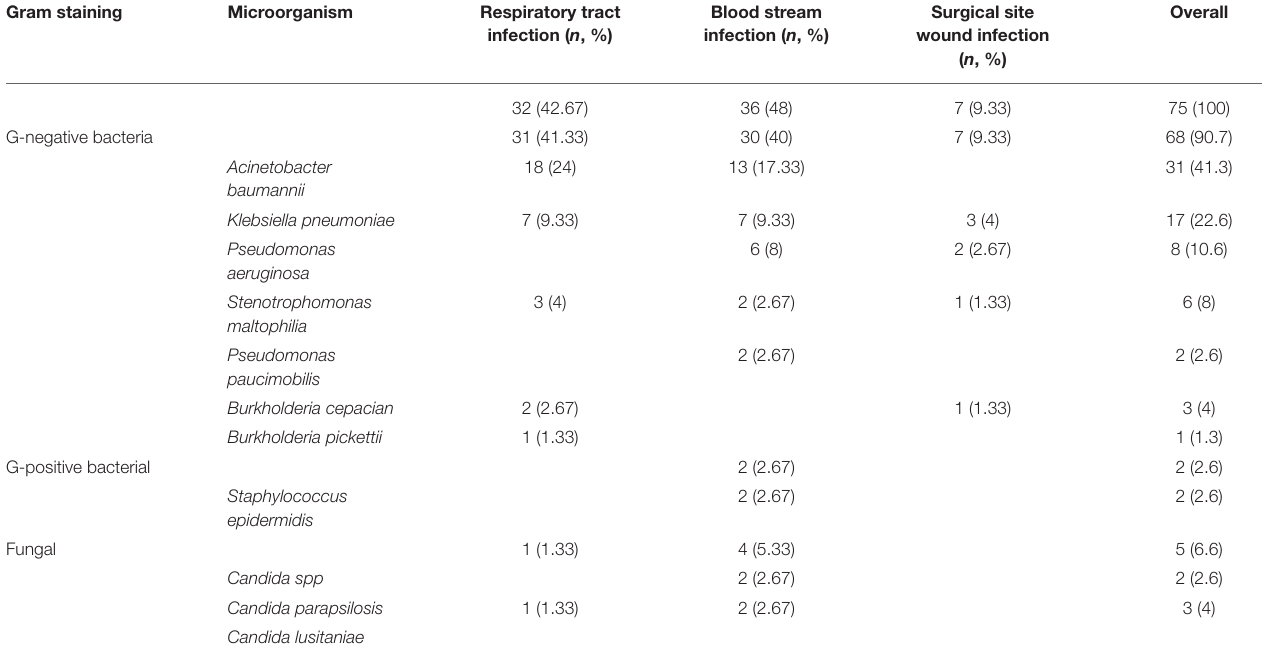
TABLE 2 | Distribution of the Microorganisms of First Nosocomial Infection. Gram staining Microorganism Respiratory tract